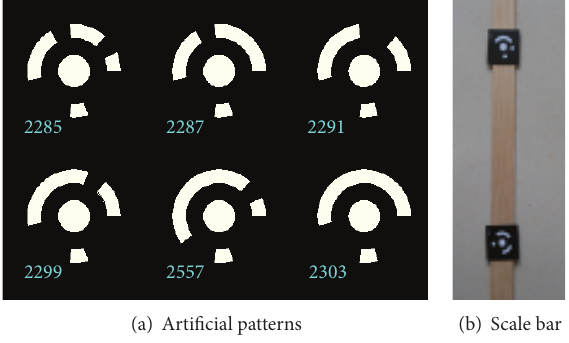
Figure 2: Patterns and scale bar used in this